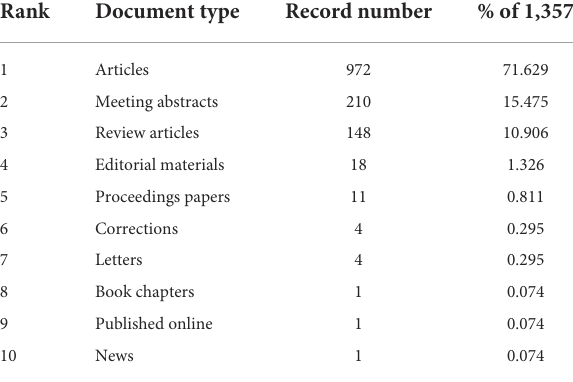
TABLE 1 Document types of the